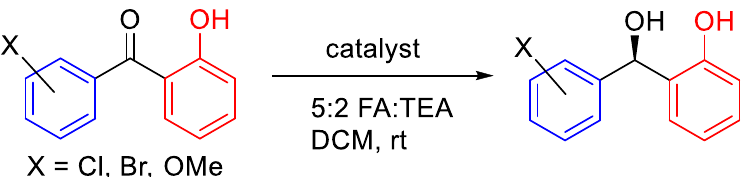
Figure 8. ATH of ortho -hydroxy benzophenones using tethered ATH complexes. The configuration of alcohol product 5 was confirmed after methylation by comparison of the HPLC of reduction product 6, the configuration of which is known in the literature (Figure 9).